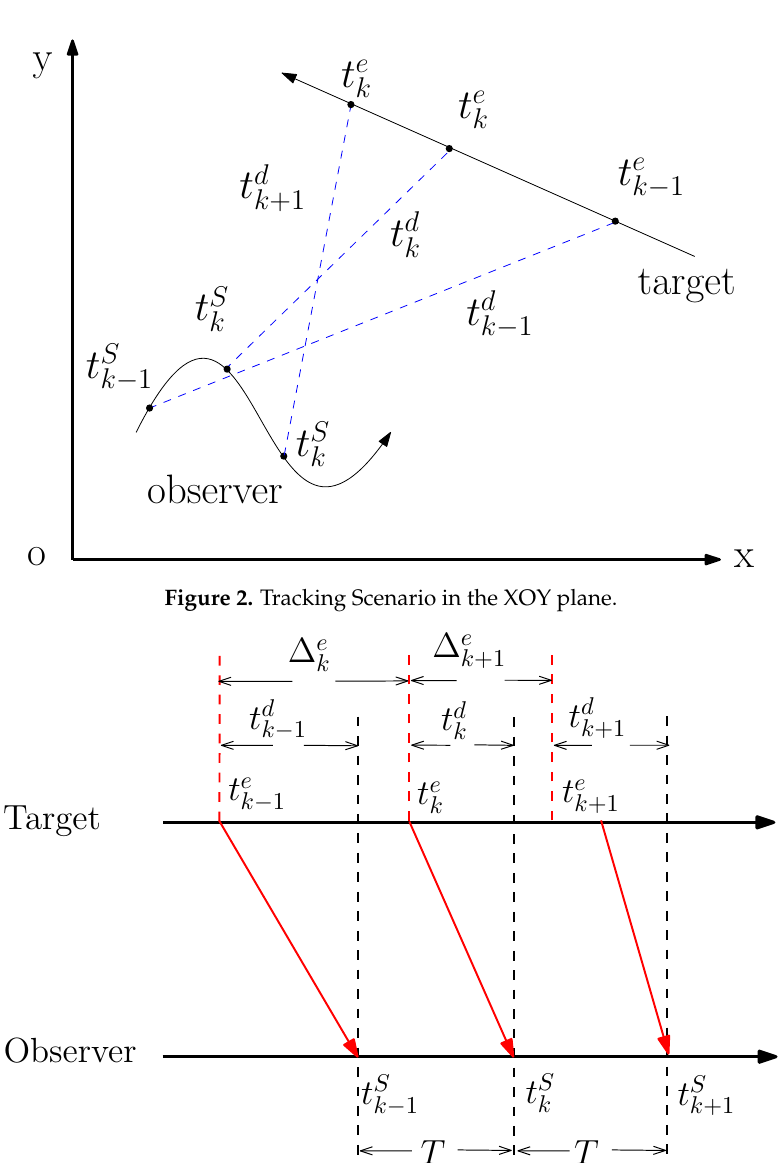
Figure 3. The illustration of time